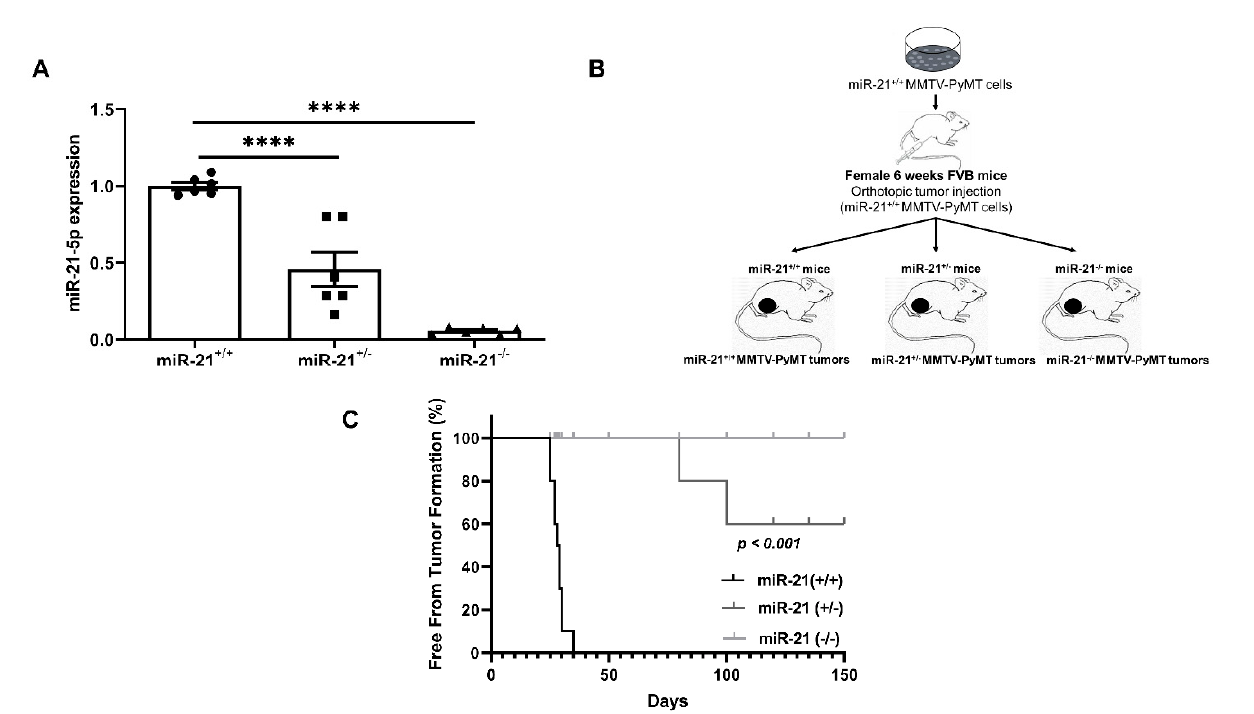
Figure 2. Genetic deletion of miR-21 protects against breast tumor formation. In the orthotopic model, 1 × 10 6 MMTV-PyMT cells were injected into the mammary fat pad of miR-21 +/+ , miR-21 +/ − and miR-21 − / − ( n = 10 mice/group). ( A ) miR-21 expression in mammary fat pads of miR-21 +/+ , miR-21 +/ − and miR-21 − / − , determined by one-way ANOVA and represented as mean ± SEM, (****— p < 0.0001, n = 2 mice/group; ● —Individual replicates of miR-21 +/+ tumors, ▪ —Individual replicates of miR-21 +/ − tumor, ▲ —Individual replicates of miR-21 − / − tumors). ( B ) Schema. ( C ) Tumor formation was noted in all miR-21 +/+ and 45% of miR-21 +/ − mice, but the miR-21 − / − had 0% tumor formation at 150 days determined by Mantel–Cox test ( p < 0.001, n = 10 mice/group).